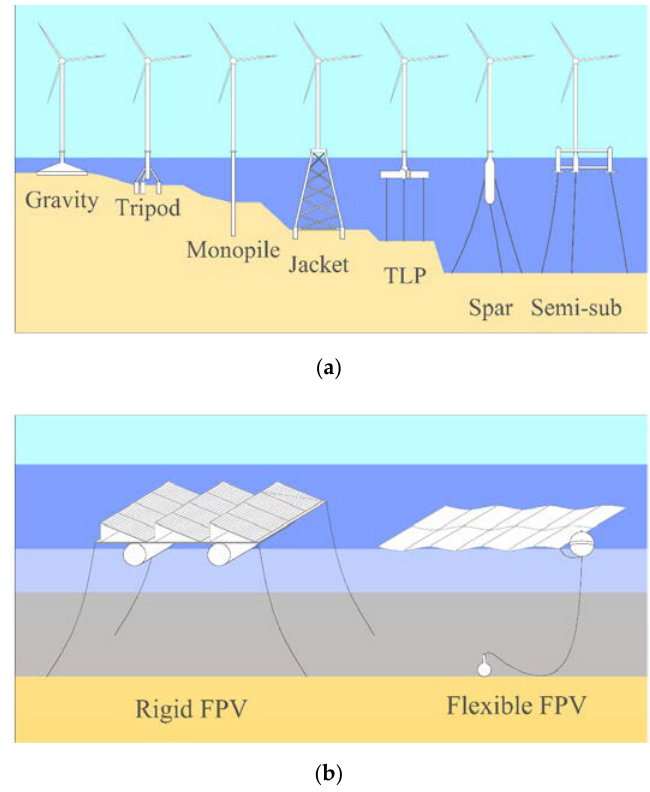
Figure 1. Different types of offshore wind turbine foundations ( a ) and floating photovoltaic (FPV) Figure 1. Di ff erent types of o ff shore wind turbine foundations ( a ) and floating photovoltaic (FPV) systems ( b ). systems ( b